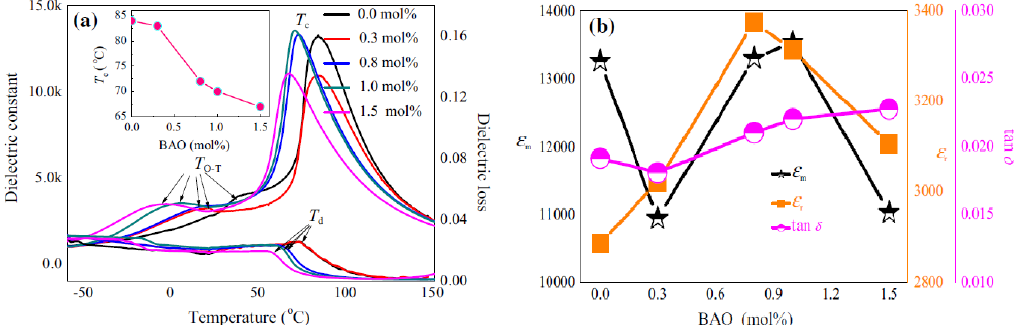
Figure 8. The temperature dependence of ε r and T C for (1 − x)BCZT–xBAO ceramics measured at 1 kHz ( a ). The maximum dielectric constant ( ε m ), dielectric constant ( ε r ), and dielectric loss ( tan δ ) of BCZT ceramics with di ff erent BAO contents ( b ). Reprinted with permission from [76]. Copyright 2015 Springer